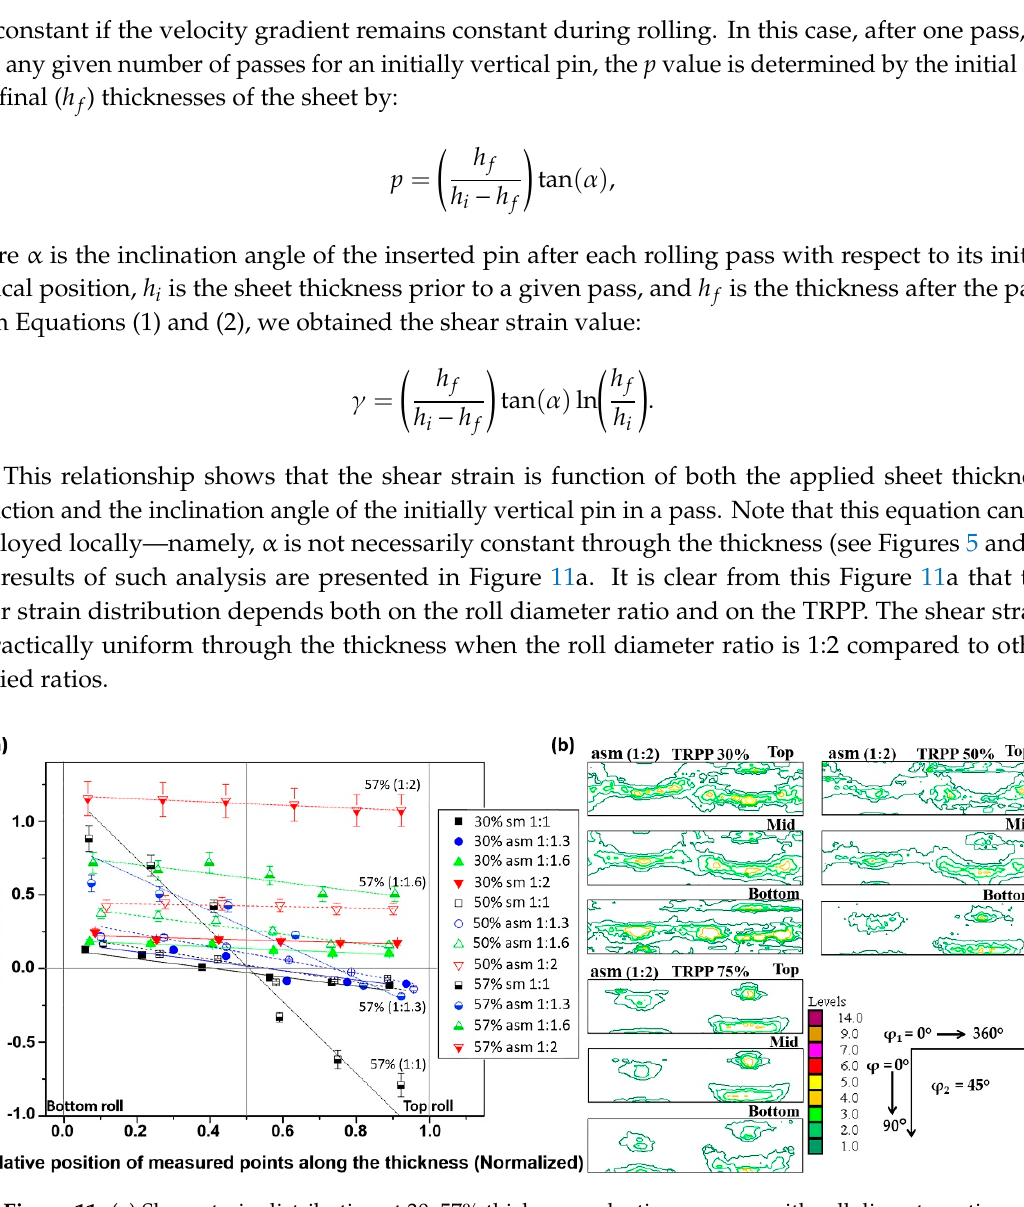
Figure 11. ( a ) Shear strain distribution at 30–57% thickness reduction per pass with roll diameter